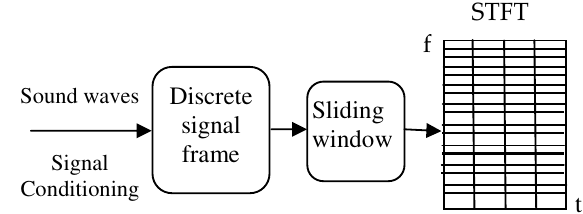
Figure 9. Describe the process selected feature